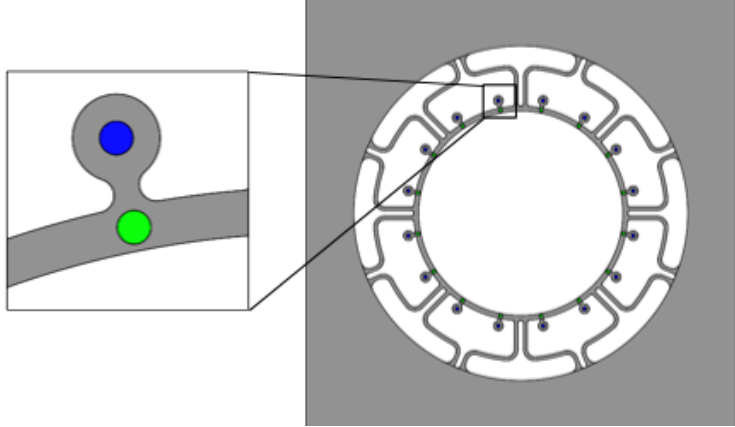
Figure 4. Punch 16 holes evenly on the mass blocks and the ring, respectively.